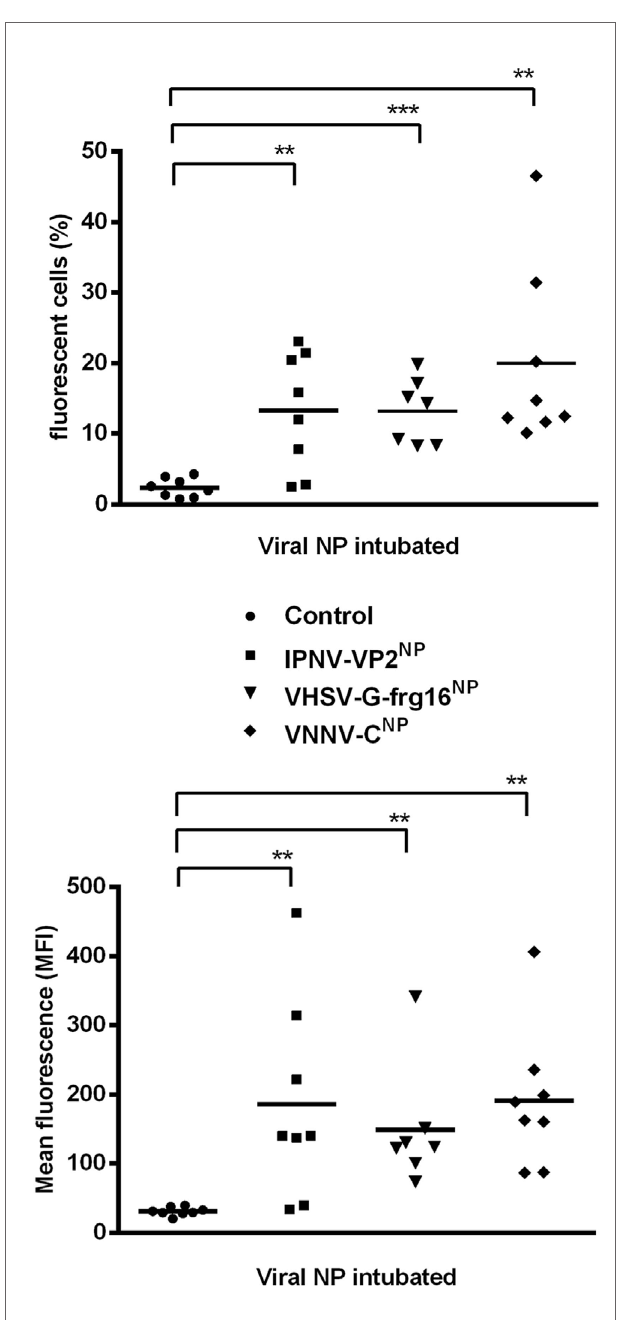
FigUre 5 | Uptake of nanopellets (NPs) by zebrafish via intubation. Adult zebrafish were intubated with 20 μ g/fish of each fluorescently labeled NP in 30 µl PBS for 5 h ( n = 8), then intestine cells were sampled for cytometry. ● Control fish: 30 µl PBS intubated without NP. Each point represents data from one fish intubated with ■ IPNV-VP2 NP , ▾ VHSV-G-frg16 NP , or ♦ VNNV-C NP . Horizontal bars are the means. Differences between the mean of each treatment group and control were analyzed by an unpaired one-sided t -test with Welch’s correction for unequal variances. Significance levels * p < 0.05; ** p < 0.01; *** p <